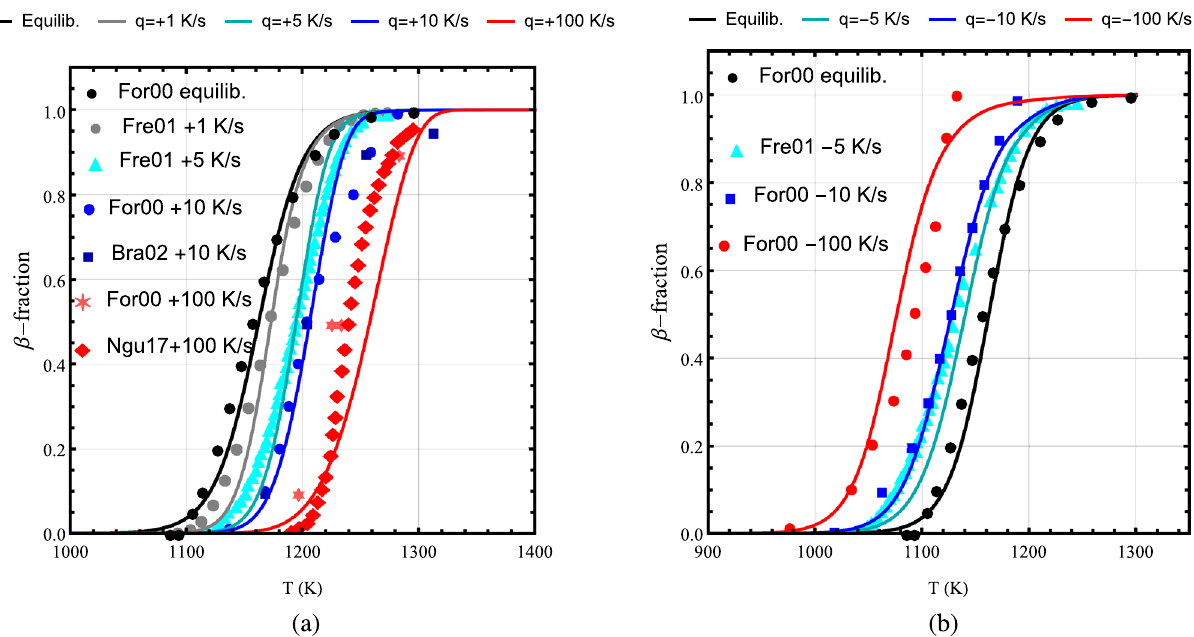
Figure 7. Volume fraction of β phase as a function of temperature calculated (lines) by using model B versus measured data (markers) for Zircaloy-4 at different heating/cooling rates (left/right panel) where q Measured data refs. are For00 11 , Fre01 21 , Bra02 20 , and Ngu17 22